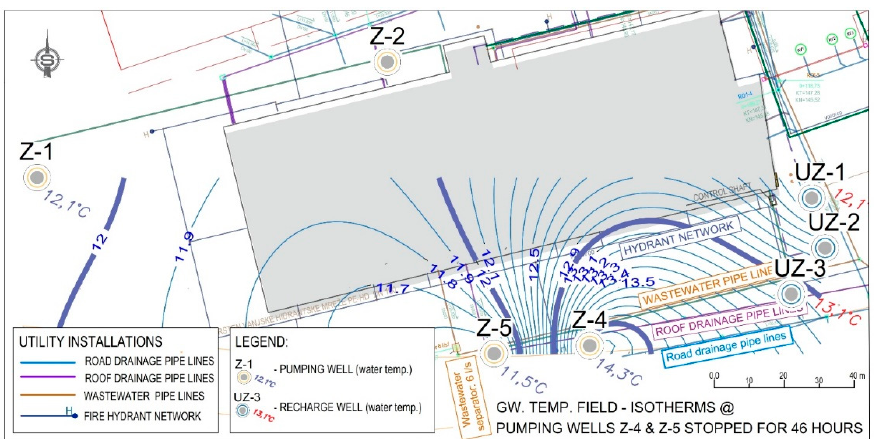
Figure 24. State of the thermal field (isotherms) in the aquifer, pumps Z-4 and Z-5 do not work.